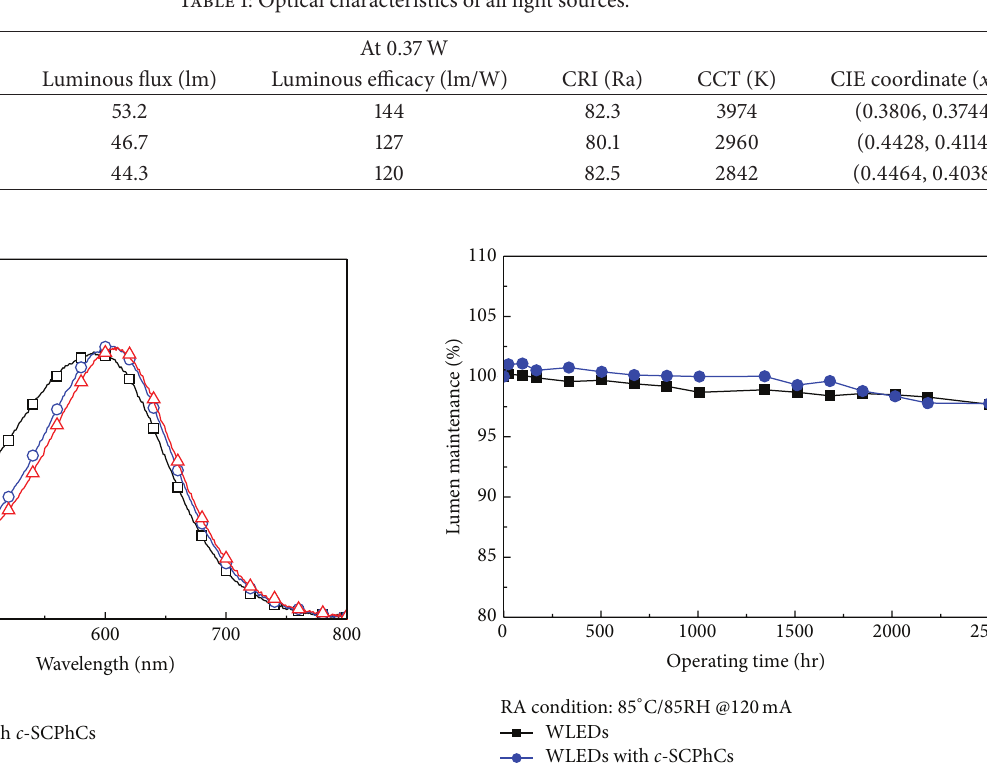
Figure 3: Luminescence spectra of the three types of WLEDs.